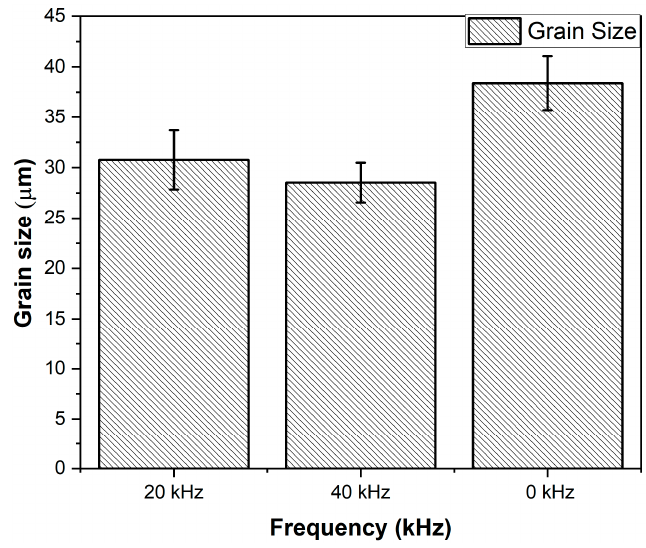
Figure 9. Grain size as a function of frequency.